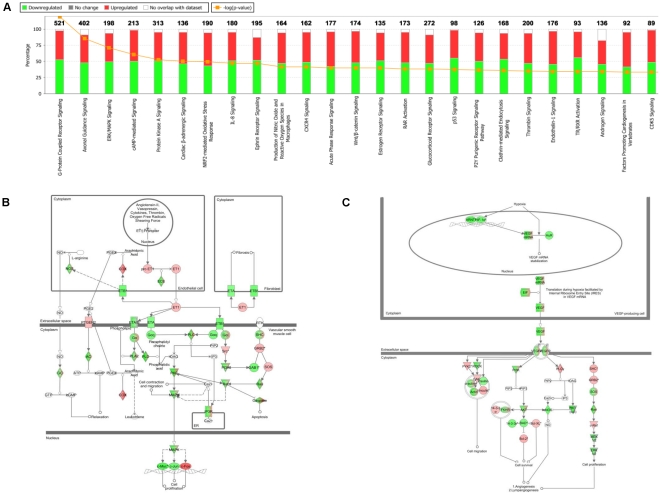
An interaction network generated using IPA analysis shows genes regulated by NKX2-3 in HIMEC.(A) The top 25 signaling pathways affected by NKX2-3 knockdown. (B) The EDN1 pathway is regulated by NKX2-3 in 2 HIMEC. IPA analysis shows genes up-regulated (red) and down-regulated (green) by NKX2-3 knockdown. (C) The VEGF-PI3K/AKT-eNOS pathway is regulated by NKX2-3 in 2 HIMEC. IPA analysis shows genes up-regulated (red) and down-regulated (green) by NKX2-3 knockdown in the VEGF-PI3K/AKT-eNOS pathway.